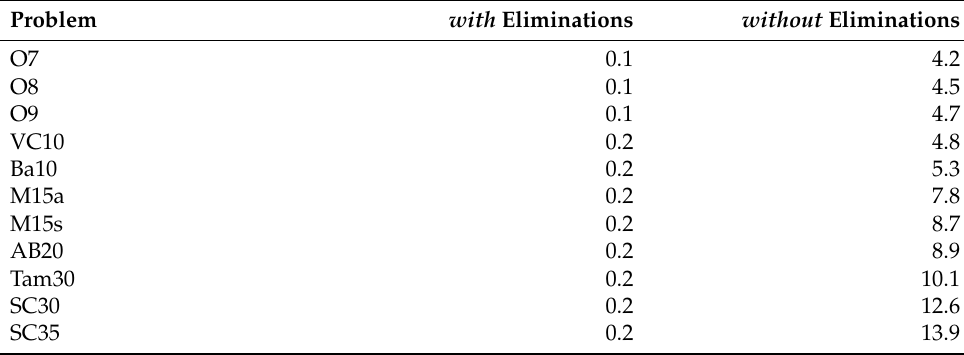
Table 3. Average CPU TIME for computing Newton Steps ( µ sec).